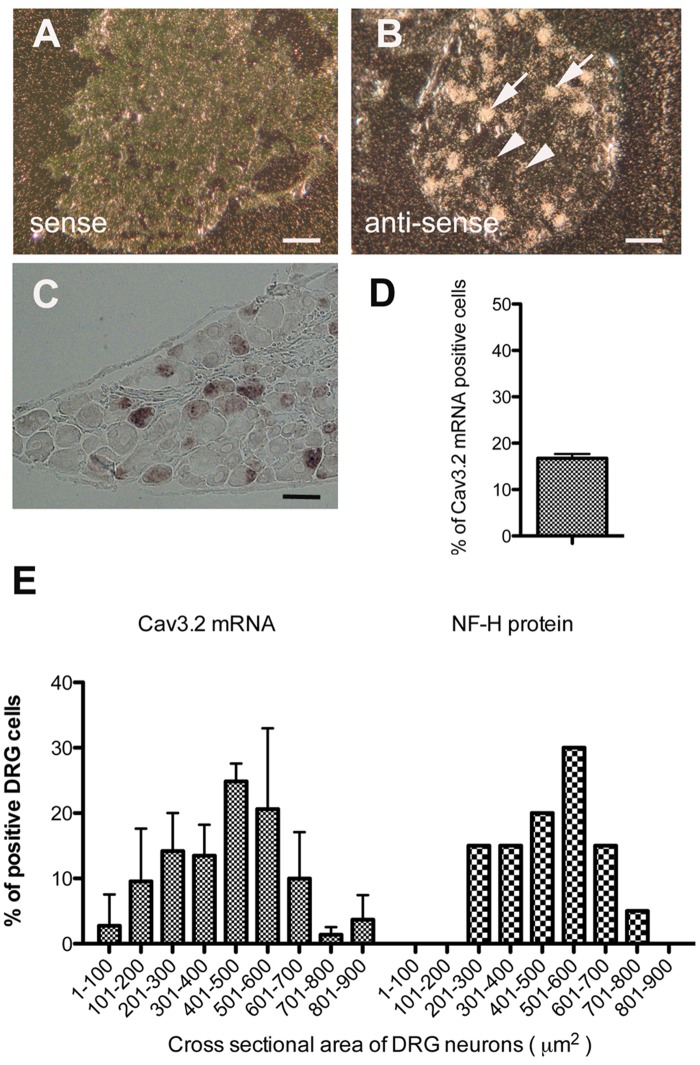
Cav3.2 mRNA is expressed in a subset of DRG neurons in normal mice.(A and B) Macroautoradiographic images of an [35S]-labeled probe from an in situ hybridization showing the specificity of the Cav3.2 probe (A; sense probe) and Cav3.2 mRNA expression (B; anti-sense probe) in mouse DRG tissues. Hybridization signals were obtained only when the anti-sense probe was used. The medium DRG neurons (arrows) were densely labeled, whereas smaller neurons (arrow head) were only weakly labeled. Scale bar = 50 μm (C) Microscopic images of a DIG-labeled probe for in situ hybridization (n = 3 mice for each probe). Scale bar = 50 μm. (D) The proportion of Cav3.2 mRNA-positive neurons relative to the total number of DRG neurons was determined. (E) Histogram showing the proportions of Cav3.2 mRNA-labeled cells based on a cross-sectional area (left). The proportion of cells labeled by an anti-NF-H antibody is shown as a reference on the right side. Only labeled cells that included nuclei were subjected to area measurements.